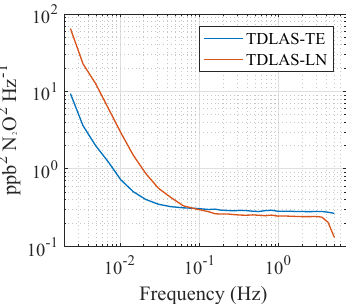
Figure 7. Mean N 2 O variance spectra of each TDLAS analyzer from 29 June to 9 July 2016.